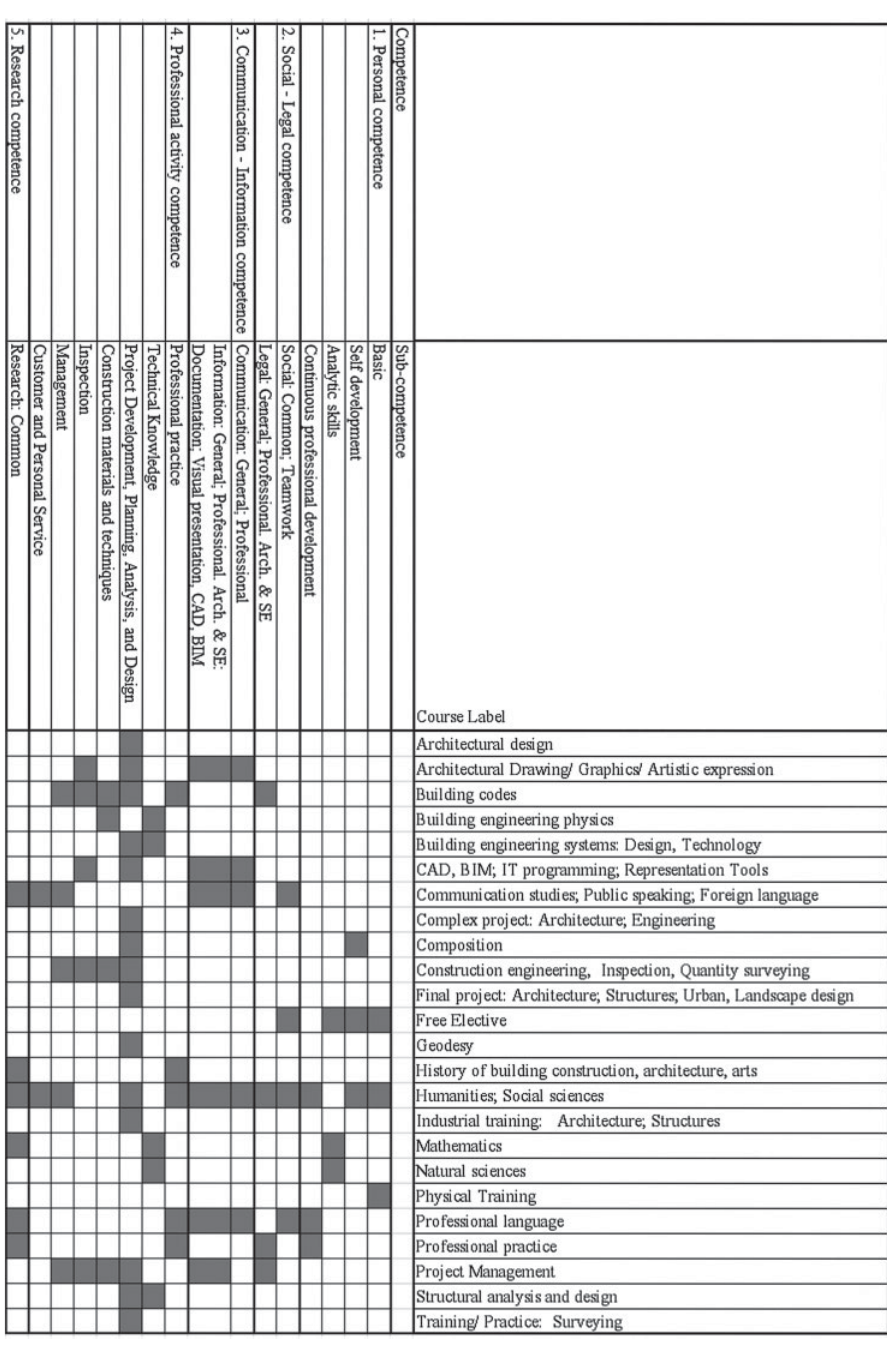
Table 2. Correlation of the proposed AE programme curriculum with the proposed CM for